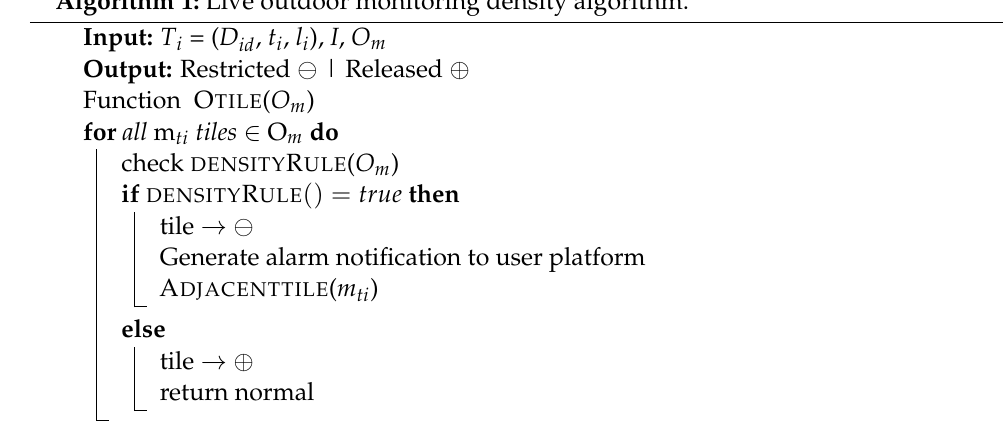
Figure 7. The proposed model is composed of multiple algorithms: monitoring crowd, estimating density count, and evaluating adjacent tile. Algorithm 1: Live outdoor monitoring density